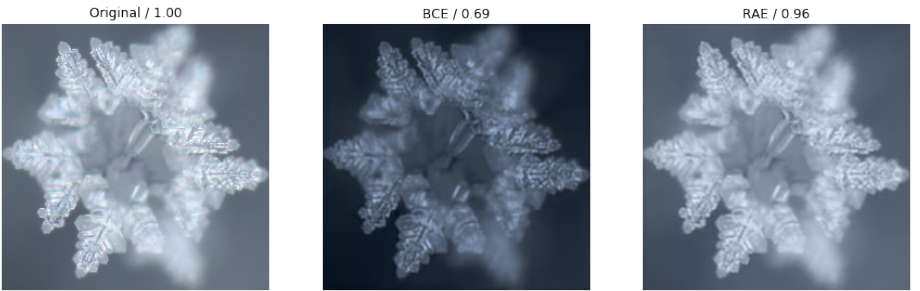
Figure 4. Reconstruct image generated by RAE model train with BCE and Spherical metric separately. The SSIM index is calculated with each reconstructed image. Spherical one outperforms the BCE